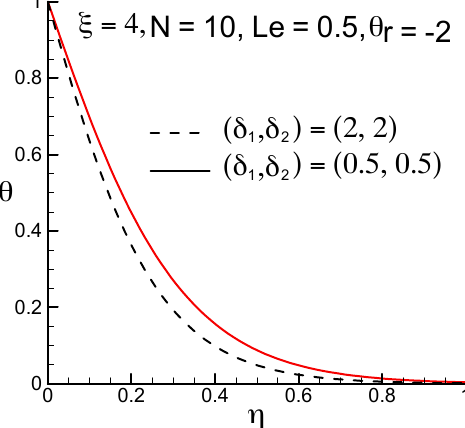
Figure 4. The dimensionless temperature profile for two values of δ 1 and δ 2